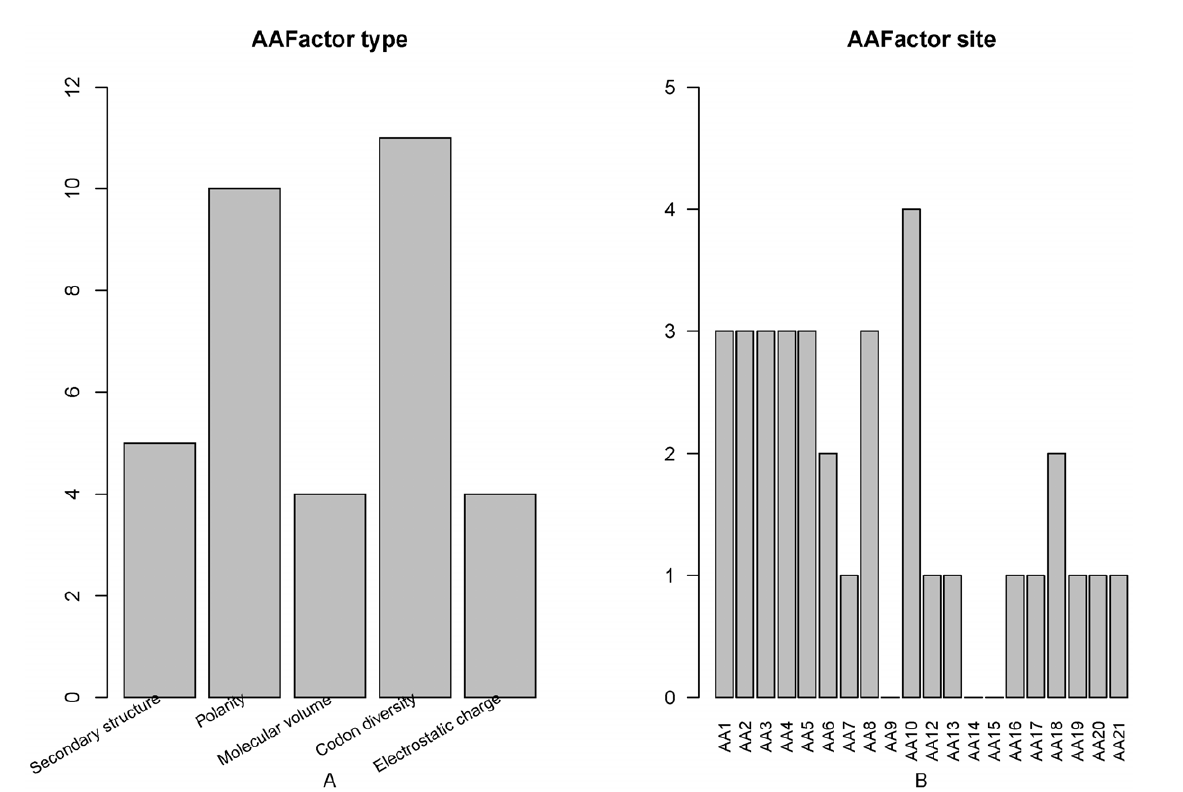
Figure 4. Feature and site specific distribution of the amino acid factor features in the optimal feature set. (A) Feature distribution of the amino acid factor features in the optimal feature set. Codon diversity and polarity features were the most important features, and secondary structure, molecular volume and electrostatic charge were almost equally important features to the PCA modification site prediction. (B) Site-specific distribution of the amino acid factor features in the optimal feature set. Residues at site 10 have the most important effect on PCA modification site prediction. Residues at site 1–5 and site 8 had relatively more effect on PCA modification site prediction.